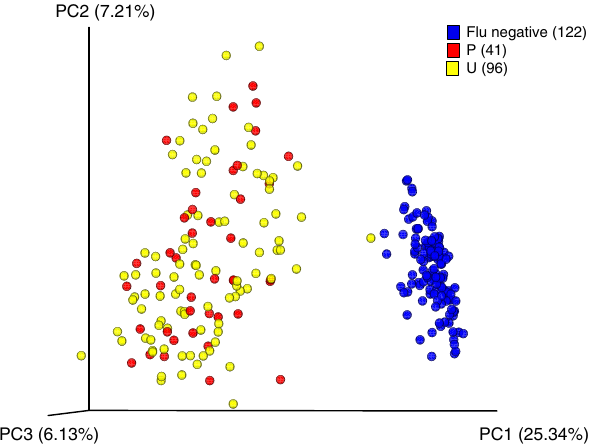
Fig. 1 Diversity of the URT microbiome of human patients infected with in fl uenza A virus (IAV). Beta-diversity analysis for longitudinal nasopharyngeal swab samples obtained from healthy and IAV-infected individuals. Principal coordinates analysis (PCoA) of Bray – Curtis distances was done for samples from humans, labeled as in fl uenza positive in red (P, indicating data points with positive IAV qRT-PCR detection), in fl uenza unknown in yellow (U, indicates time points from positive individuals that were below the qRT-PCR detection limits at different time points after the onset of symptoms), and uninfected samples in blue (Flu negative). The total variability explained by all three principal coordinates (PCs) is shown on the axes. Source data are provided as a Source Data fi